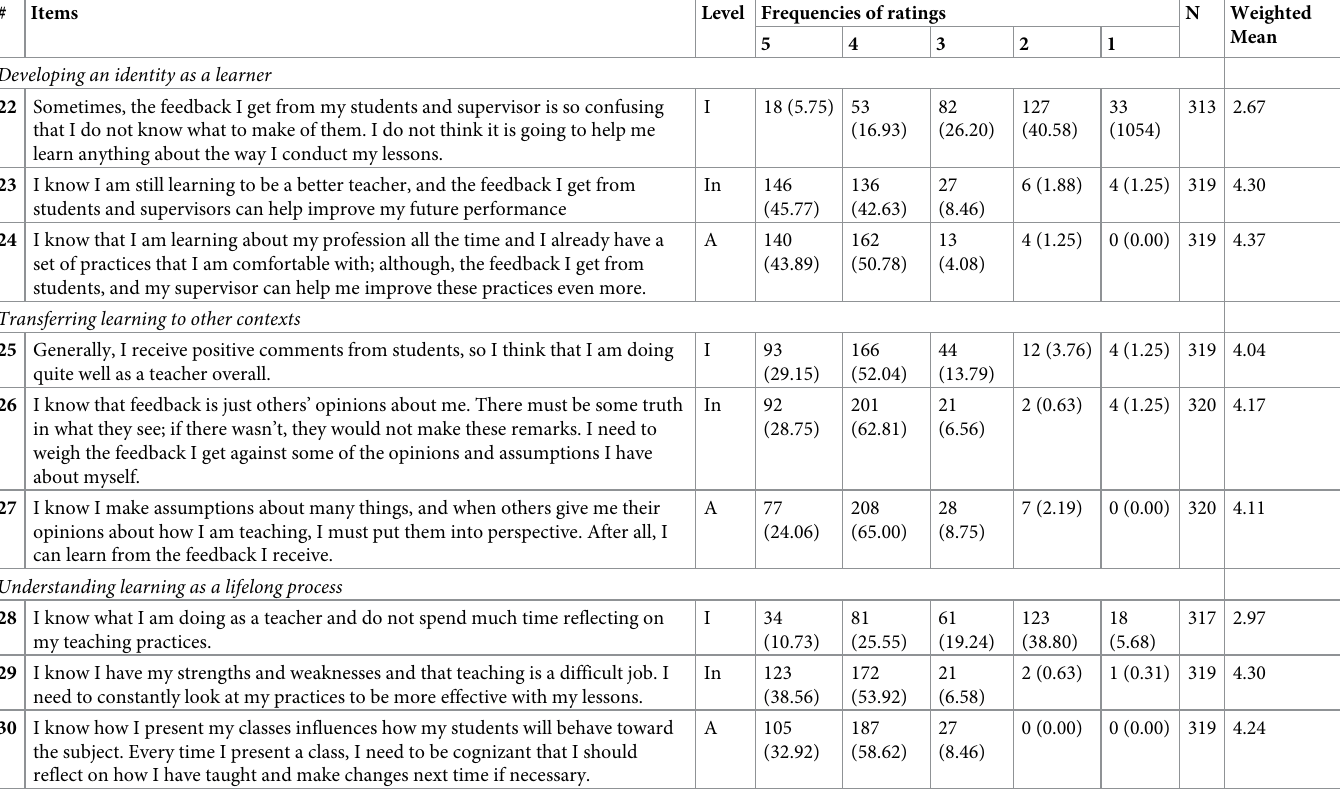
Table 3. Descriptive statistics for mathematics teachers’ developing lifelong learning